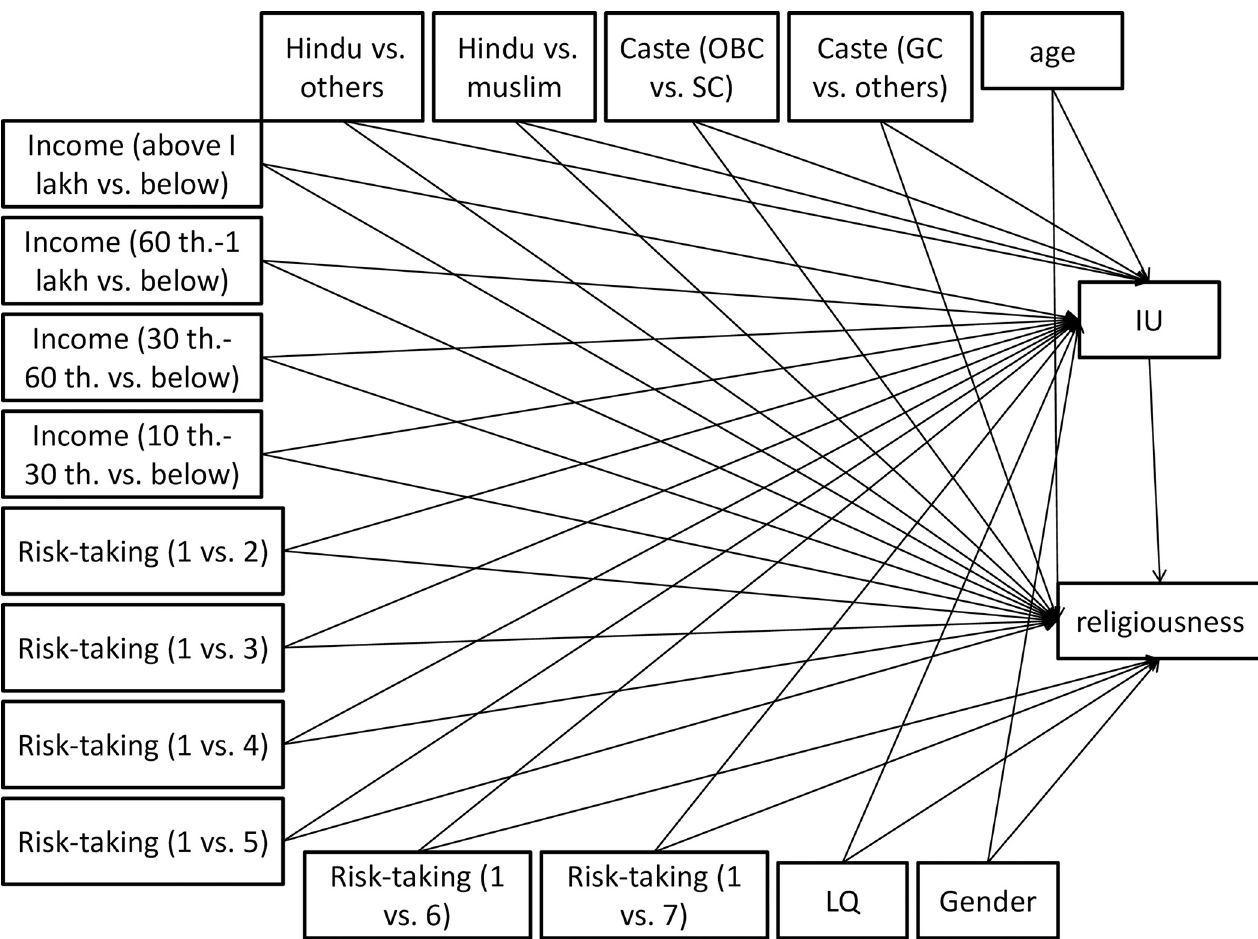
Fig 1. The conceptual path diagram shows the studied relationships of antecedent variables with IU and religiousness in the students’ sample. IU = intolerance of uncertainty, GC = general castes, OBC = other backward castes, SC = scheduled castes, th. = thousand, LQ = laterality quotient